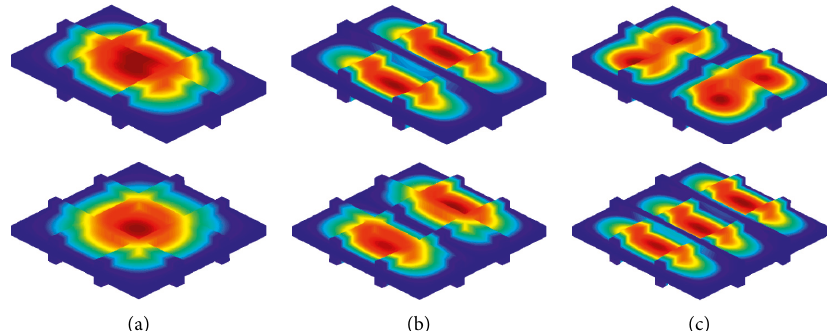
Figure 11: Some mode shapes of multi-stepped FG-CNTRC plate with SSSS boundary condition (FG-O, V ∗ η 3 =0.715). (a) Mode1. (b) Mode2. (c)